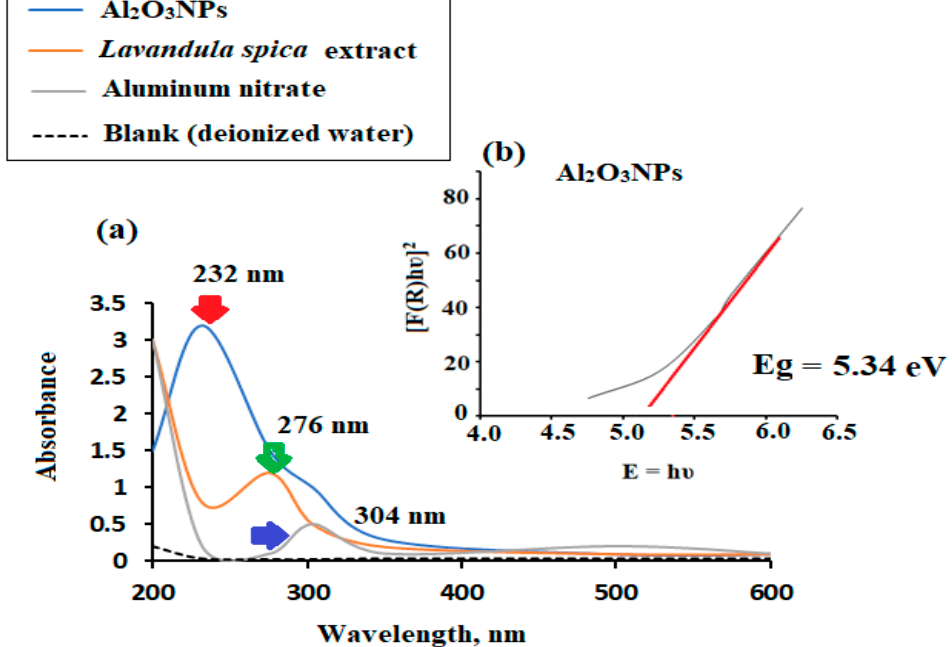
Figure 1. ( a ) UV-vis spectra of Al 2 O 3 NPs, Lavandula spica extract, aluminum nitrate, and blank (deionized) water and ( b ) the band gap of Al 2 O 3 NPs.